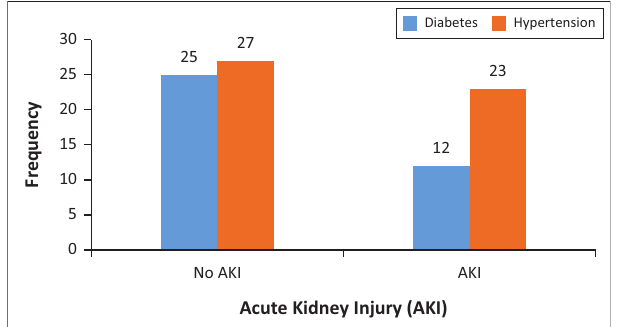
FIGURE 4: Comorbidity and acute kidney injury distribution among hospitalised patients who died due to COVID-19.